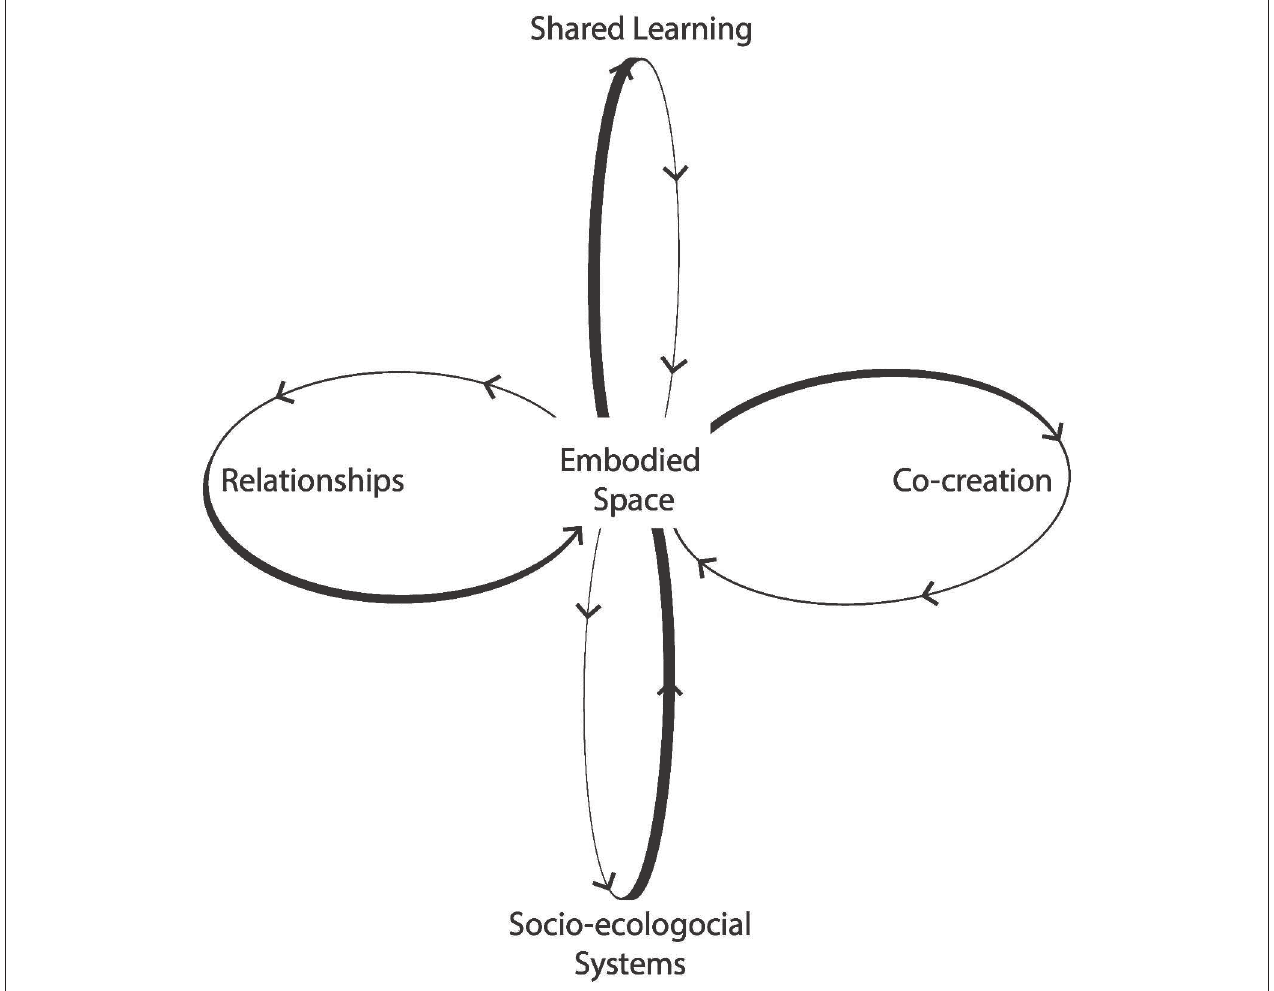
FIGURE 11 | Urban agroecology as a dynamic research framework. The vertical transformative learning cycle moves along the horizontal process loop as embodied spaces facilitate the emergence of transformative learning.